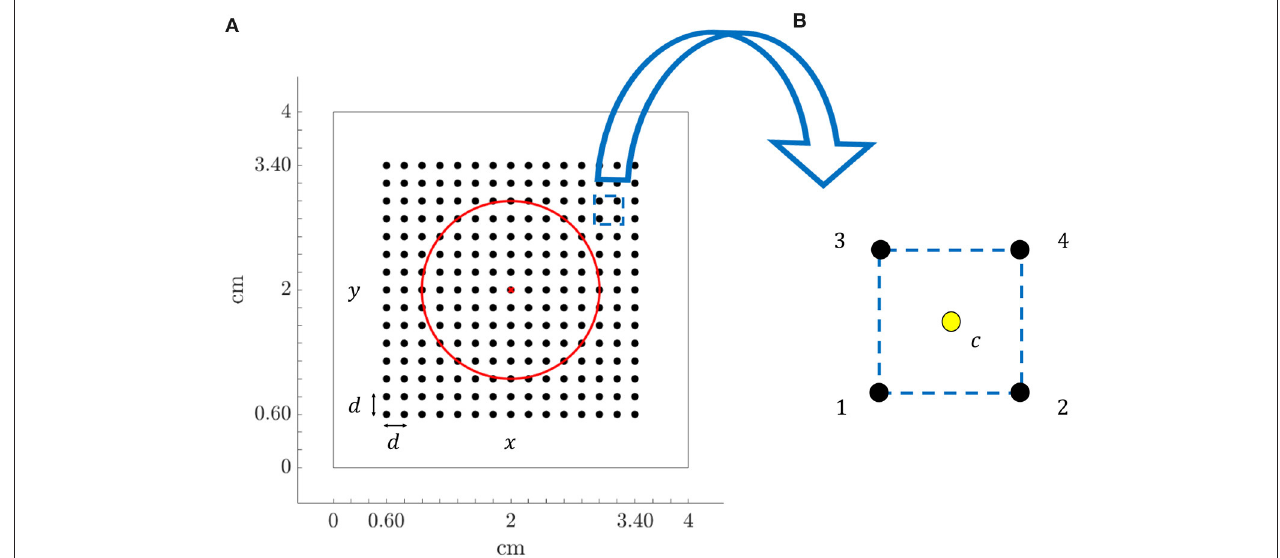
N ( N = 15) MEA electrodes (black dots) and inter-electrode spacing d = 2 mm, in the 2D FIGURE 1 | (A) Tissue geometry (4 4 cm) with overprinted the N × × Cartesian coordinate system defined by x and y . Red circle encompasses fibrotic tissue area and red cross represents the electrode located at the center of the tissue. (B) Arrangement of four electrodes (clique) from the MEA, internally denoted with 1, 2, 3, and 4, where location at the centre of the square (yellow dot) is indicated with letter c .